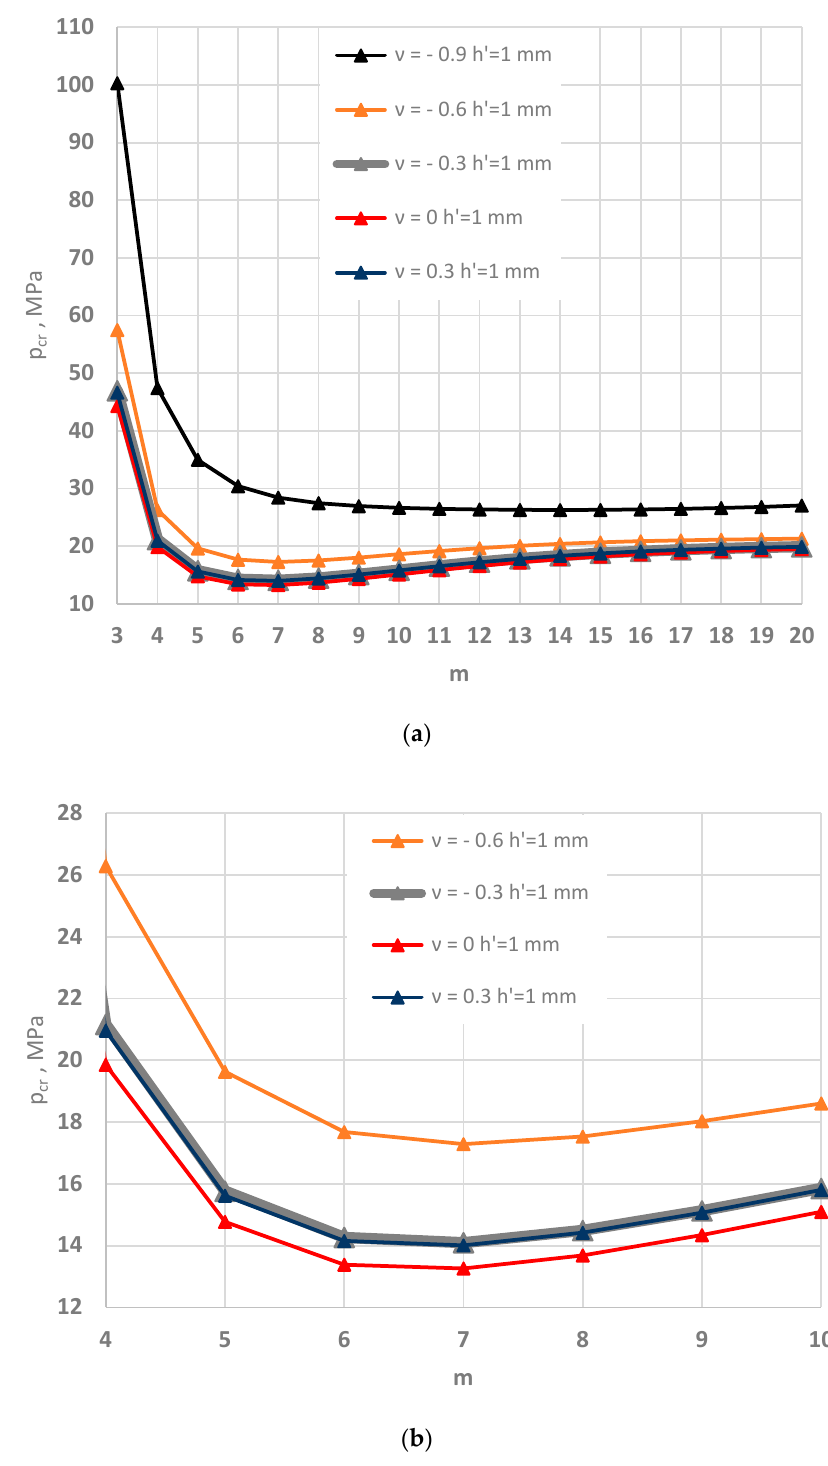
Figure 4. Critical static load p cr distribution versus mode m for plates radially stretched on the inner edge: for values of Poisson’s ratio − 0.9 ≤ ν ≤ 0.3 ( a ); for values of Poisson’s ratio − 0.6 ≤ ν ≤ 0.3 ( b ).